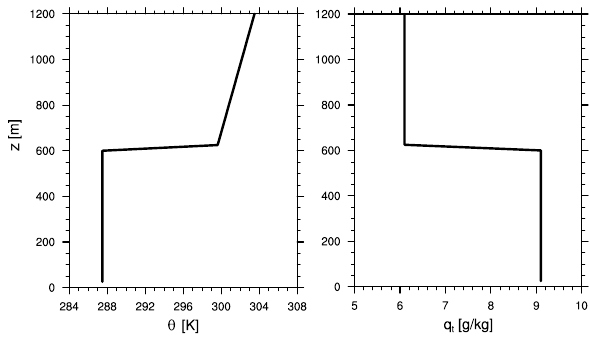
Fig. 1. Initial sounding profile (potential temperature θ and total water mixing ratio q t ) for the MSc of Control case.